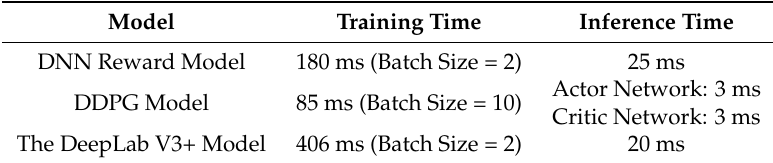
Table 4. Model training time and inference time of